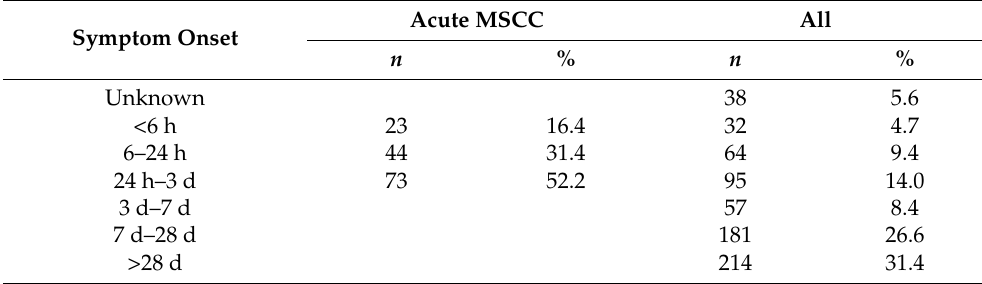
Table 2. Times of symptom onset prior to admission for acute MSCC subgroup and entire cohort. Acute Symptom Onset